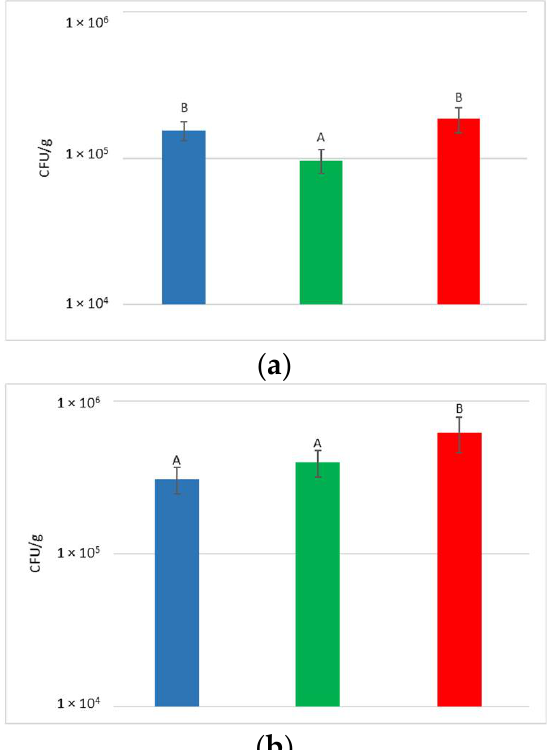
Figure 2. Total yeast ( a ) and bacteria ( b ) concentrations present on grape surfaces one week after the release of S. bacillaris in the vineyard. NT: untreated control (blue), LCC: low cell concentration (green), HCC: high cell concentration (red). Data are expressed as the average of three replicates ± standard deviation. For each figure, different letters indicate significant differences between values ( p =